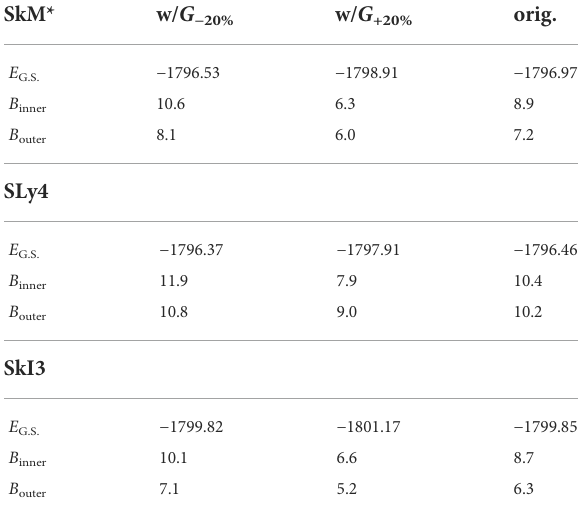
TABLE 2 E G . S . , B inner , and B outer in MeV along the fi ssion path of 236 U for three EDFs and three values of pairing strength G . SkM* w/ G − 20% w/ G +20% orig.